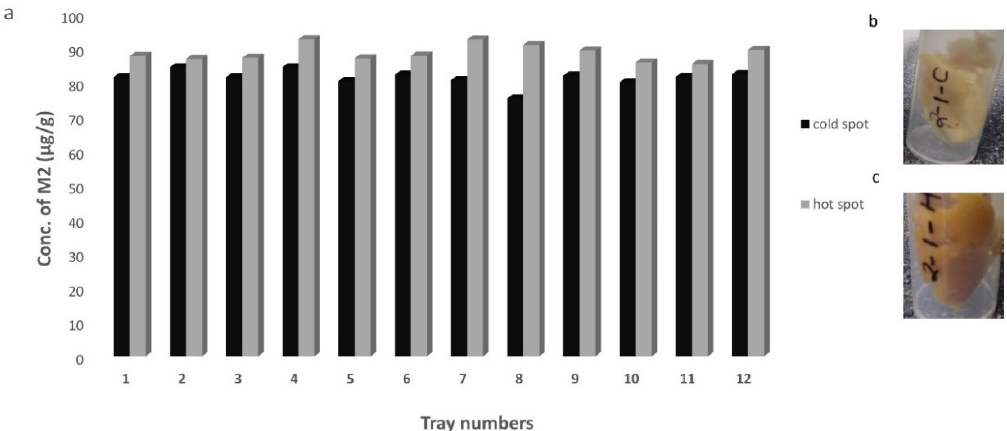
Figure 3. Concentration of M2 ( µ g / g of mashed potato) at the hot spot (grey bars) and the cold spots (black bars) determined on each tray ( a ) and visual representation of as an example of samples from the cold spot ( b ) and hot spot ( c ) scooped out from a mashed potato tray after CiMPAS processing at R-121. Similar letters among the bars indicate no significant difference ( p > 0.05).